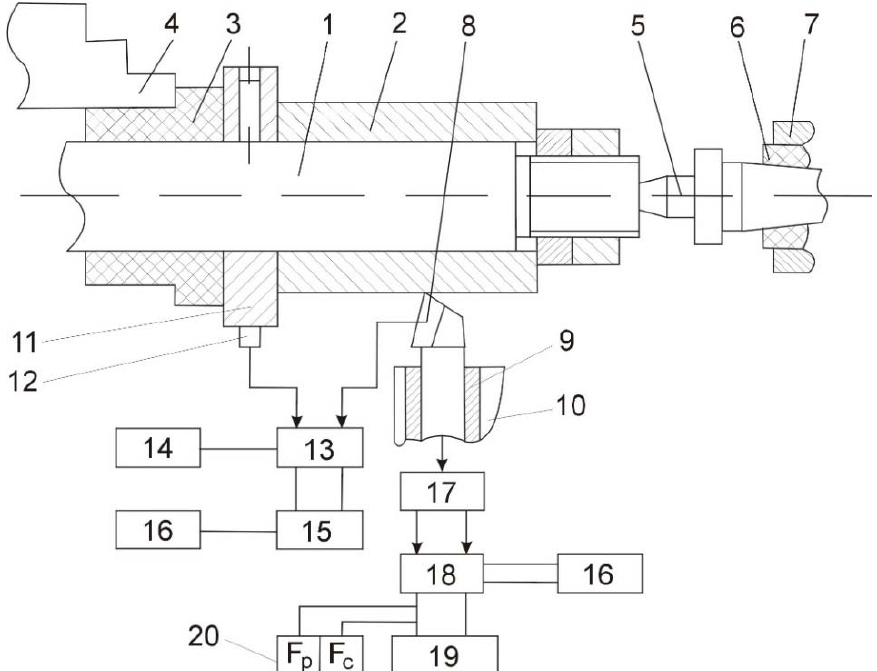
Figure 2. Schematic of the test stand: 1—work holding device, 2—workpiece, 3—dielectric sleeve, 4—machine tool holder, 5—rear center, 6—dielectric sleeve, 7—tailstock, 8—cutting edge, 9—tool holder, 10—tool post, 11—ring, 12—current measuring device, 13—vacuum switch, 14—electro-contact heating device, 15—voltmeter F4214, 16—ferroresonance voltage stabilizer, 17—dynamometer, 18—tensostaion UT4-1, 19—recording device N327/3, 20—measuring block.